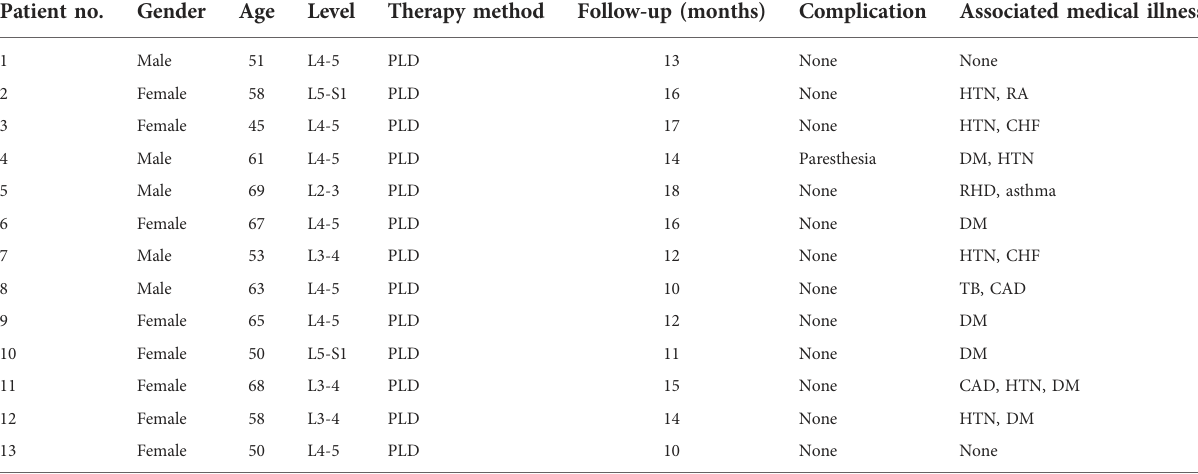
TABLE 1 Information of patients. Patient